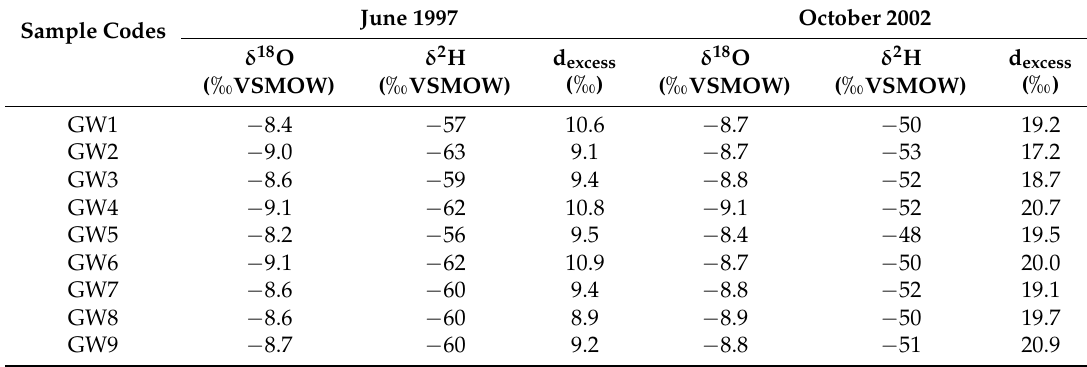
Table 2. Isotope composition of spring water samples collected in October 2002 and in June 1997. Sample